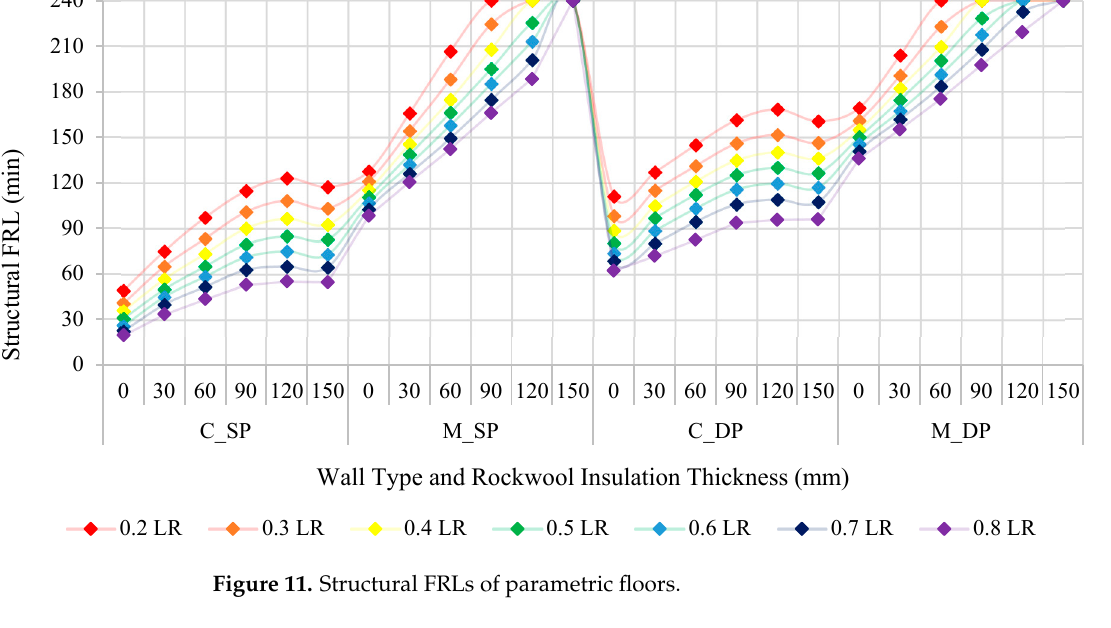
Figure 11. Structural FRLs of parametric floors.